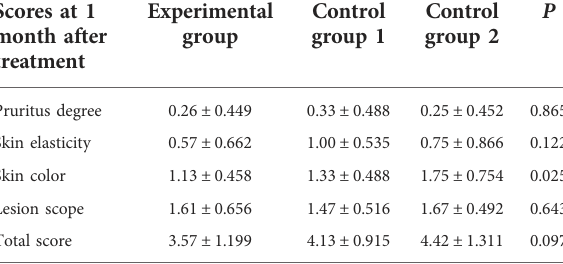
TABLE 4 Comparison among three groups at 1 month after treatment. Scores at 1 month